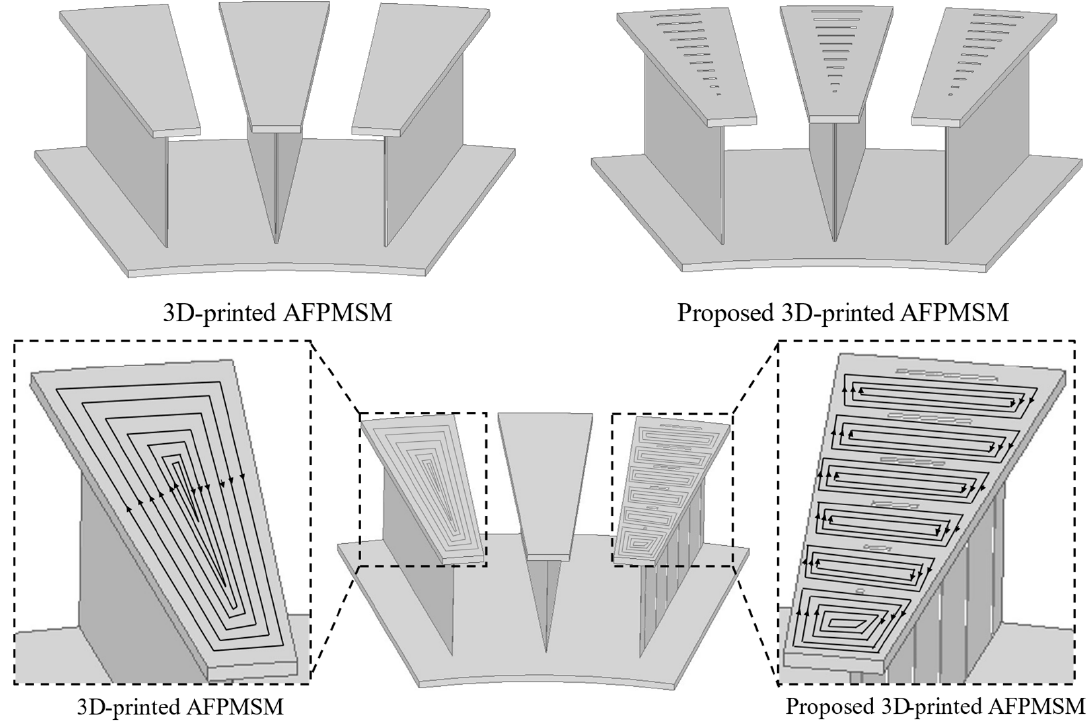
Figure 4. Design comparison between the conventional 3D-printed AFPMSM and proposed 3D- printed AFPMSM [16].